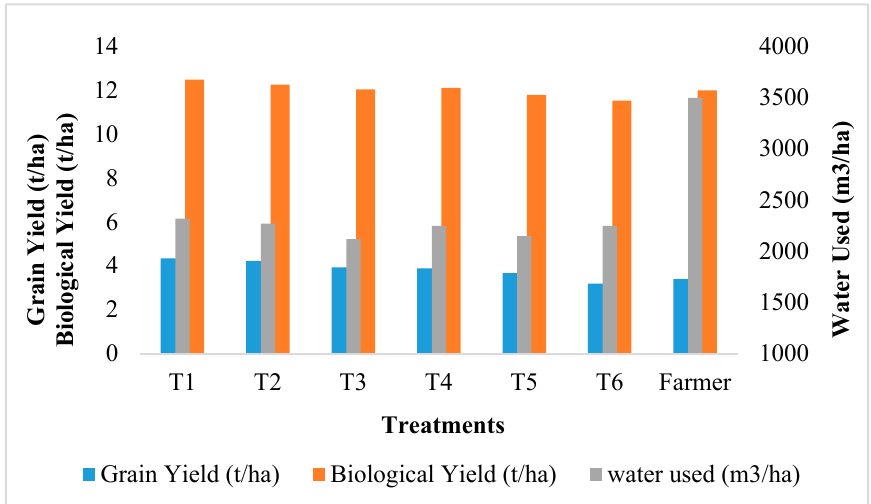
Figure 1. Graphical representation of grain yield, biological yield and water use.